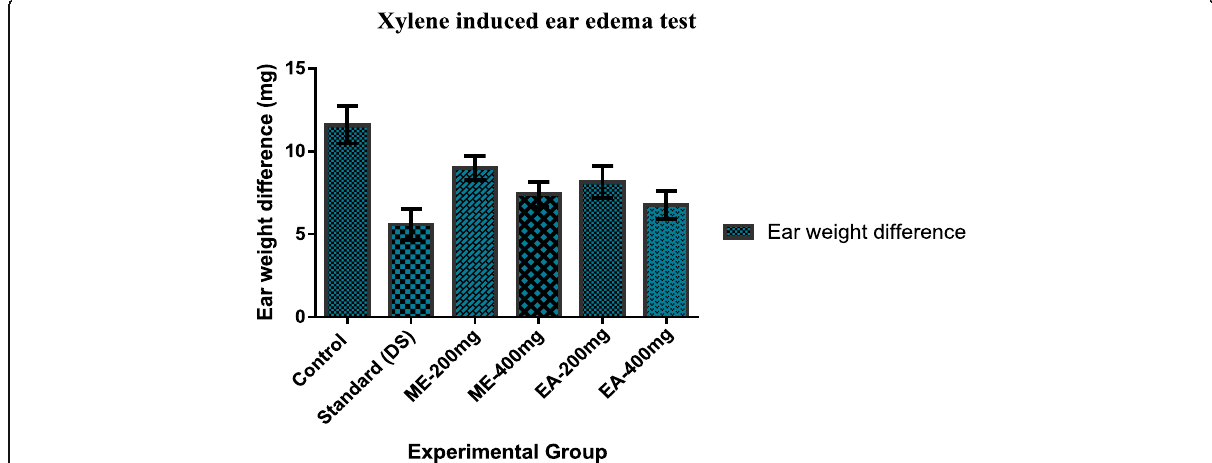
Fig. 1 Effect of Hemigraphis alternata methanolic and ethyl acetate extract treatment on xylene-induced ear edema in mice. Each bar represents the mean ± standard error of the mean of ear edema weight of five animals